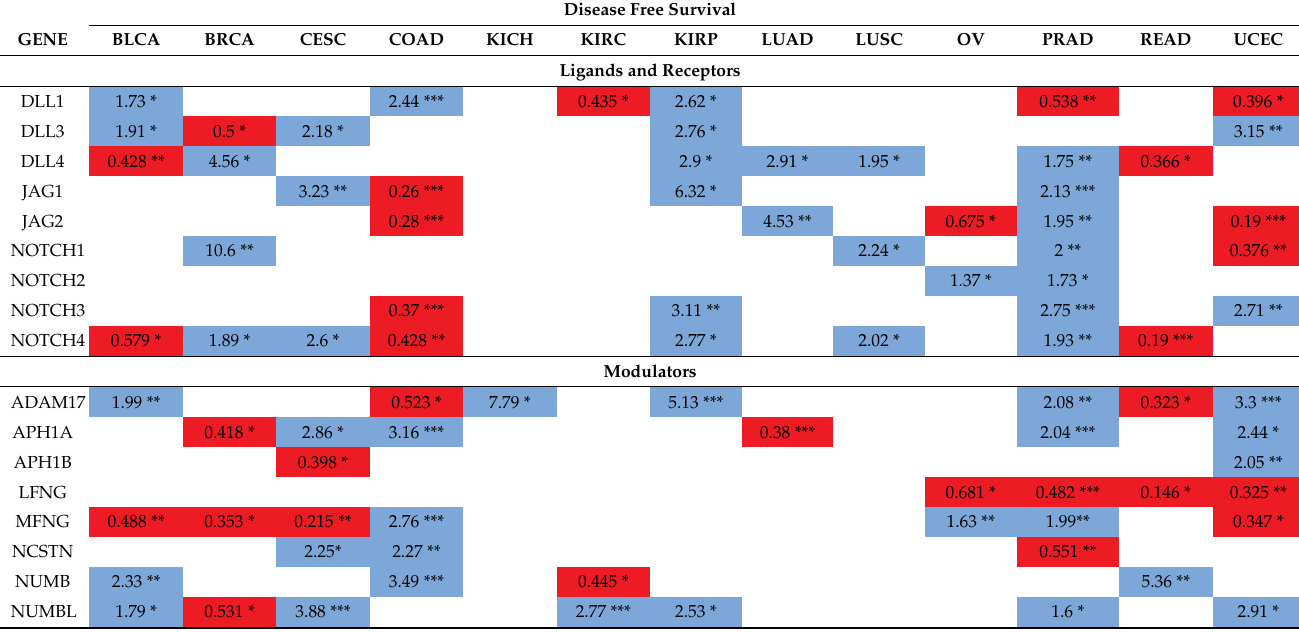
Table 2. Prognostic effect of the chosen Notch pathway members on DFS in the analyzed tumors. Value represents HR with statistical significance and the color indicates expression level correlated with favorable prognosis: red—higher expression favorable, blue—lower expression favorable (level of the expression is considered relative to the determined